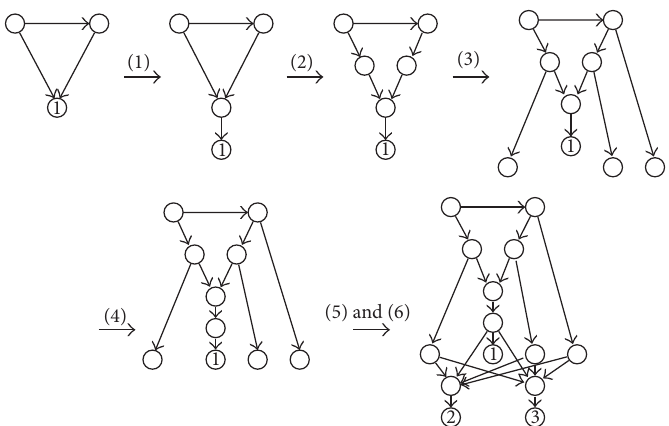
Figure 3: An example of the construction involved in the reduction of the isomorphism of 𝑆 -rDAGs to the isomorphism of TSTC networks.